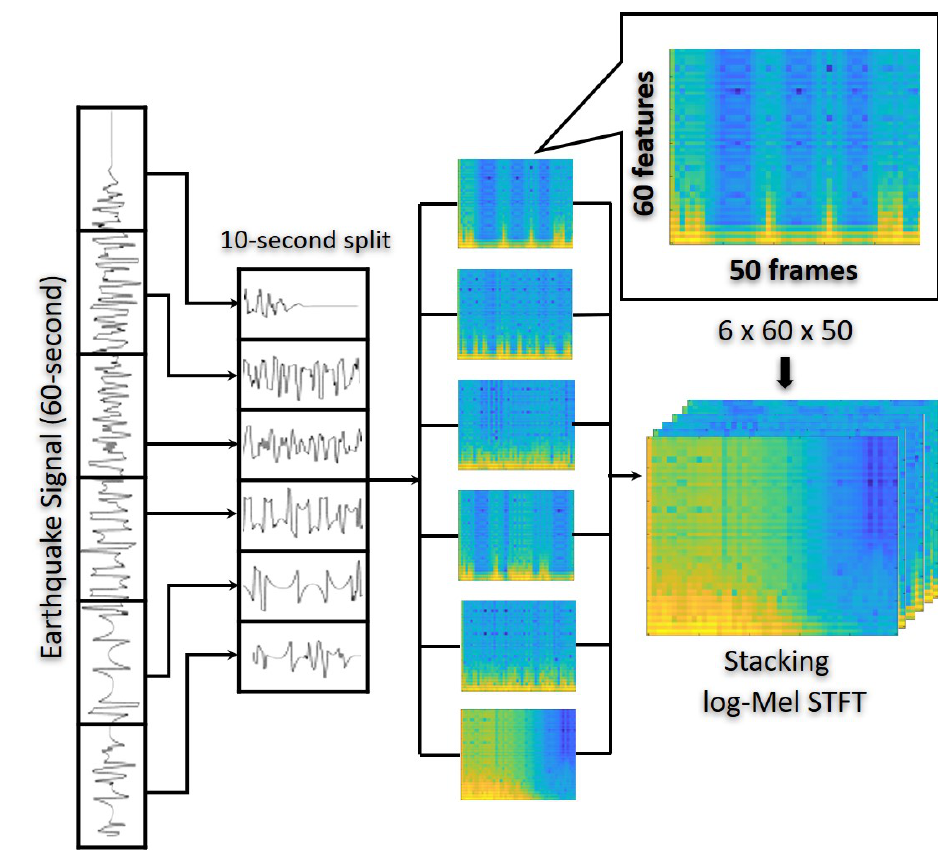
Figure 5. The data input pipeline for 3D-CNN RNN network: Feature extraction using log-Mel